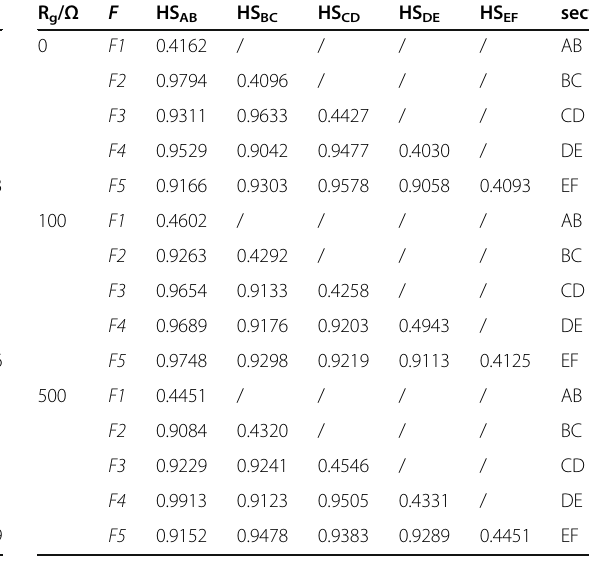
Table 5 Results of the proposed positioning method ( φ = 0 ∘ ,